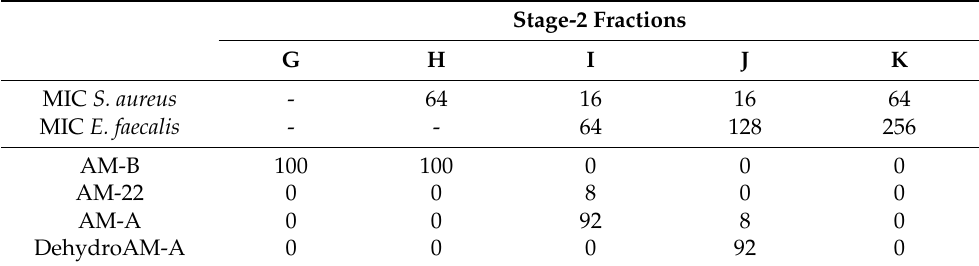
AM-A DehydroAM-A